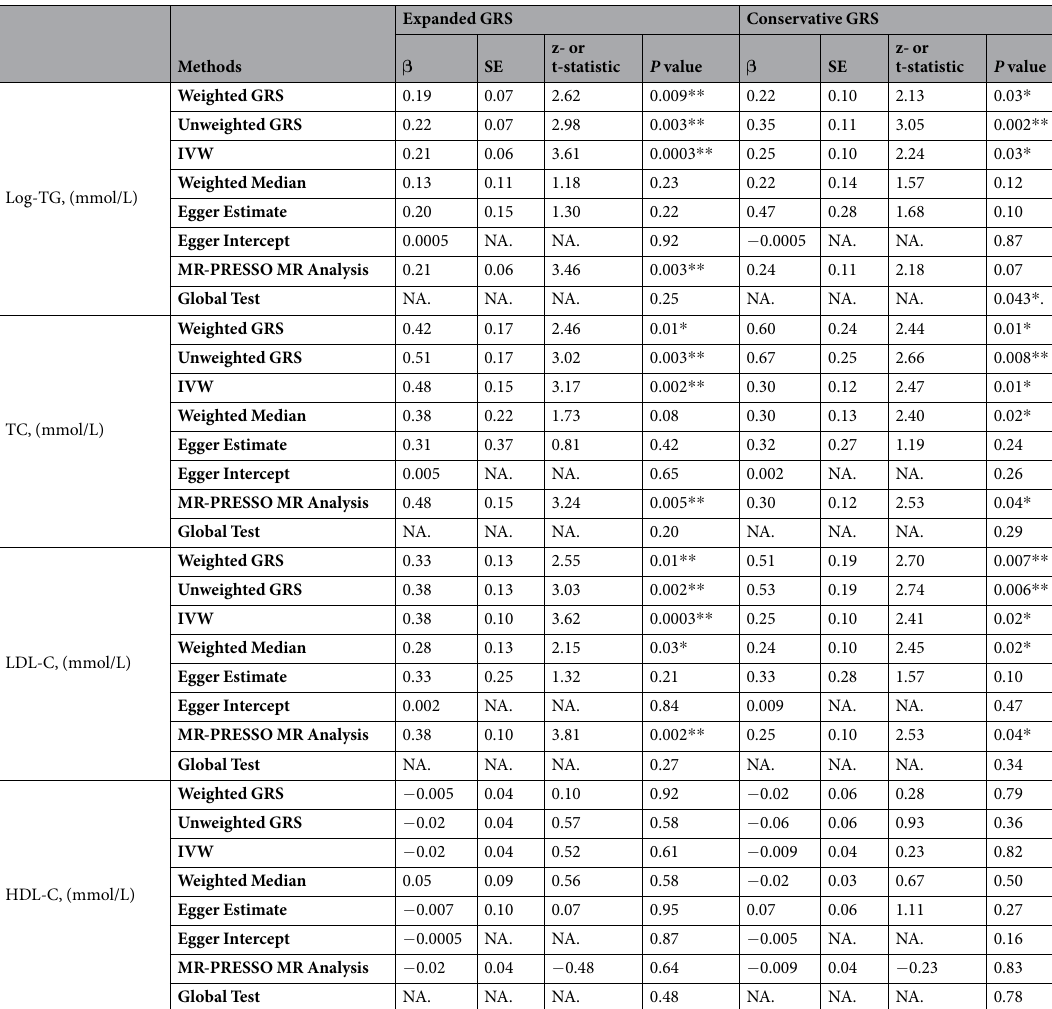
MR-PRESSO MR Analysis Global Test NA. NA. 0.78 Table 2. Sensitivity analysis for causal association of HbA1c with lipids (mmol/L) by unweighted GRS, IVW, Weighted median, MR-Egger and MR-PRESSO methods. IVW, inverse-variance weighted method, Egger, MR- Egger method. MR-PRESSO, Mendelian randomization pleiotropy residual sum and outlier. For MR-PRESSO MR Analysis, outcomes of the outlier-corrected analysis were presented if outliers were detected, otherwise it would be the raw MR analysis. NA., not applicable. The t statistics were calculated for MR-PRESSO while z statistics for the other analysis. P value were calculated from multivariable-adjusted linear regression. * P < 0.05; ** P < 0.01. All data were calculated under the full model with age, sex, BMI, systolic and diastolic blood pressure, smoking and drinking status, physical activity status, and diabetes